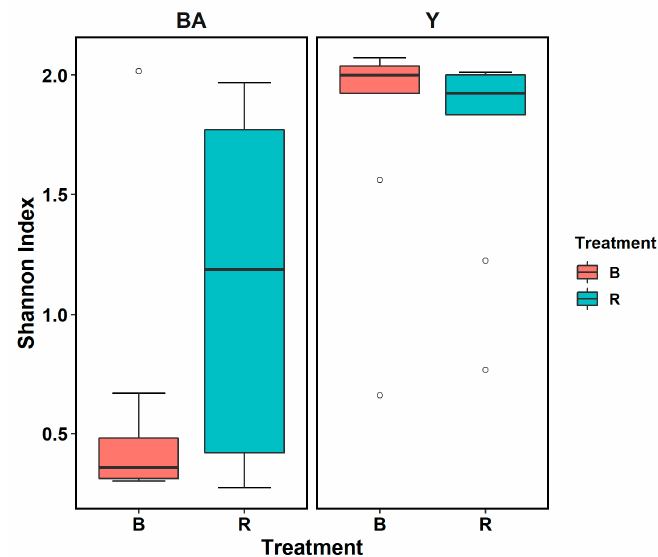
Figure 4. Box plots illustrating the alpha diversity index (Shannon diversity) in bacterial microbiomes from different agro-management: organic (Y) and conventional (Ba); and at different sampling locations: between (B) the plant rows and in the vine rows (R). The horizontal line in the box plot indicates the median, and the box indicates the upper and lower quartiles, with the vertical lines representing the minimum and maximum values.